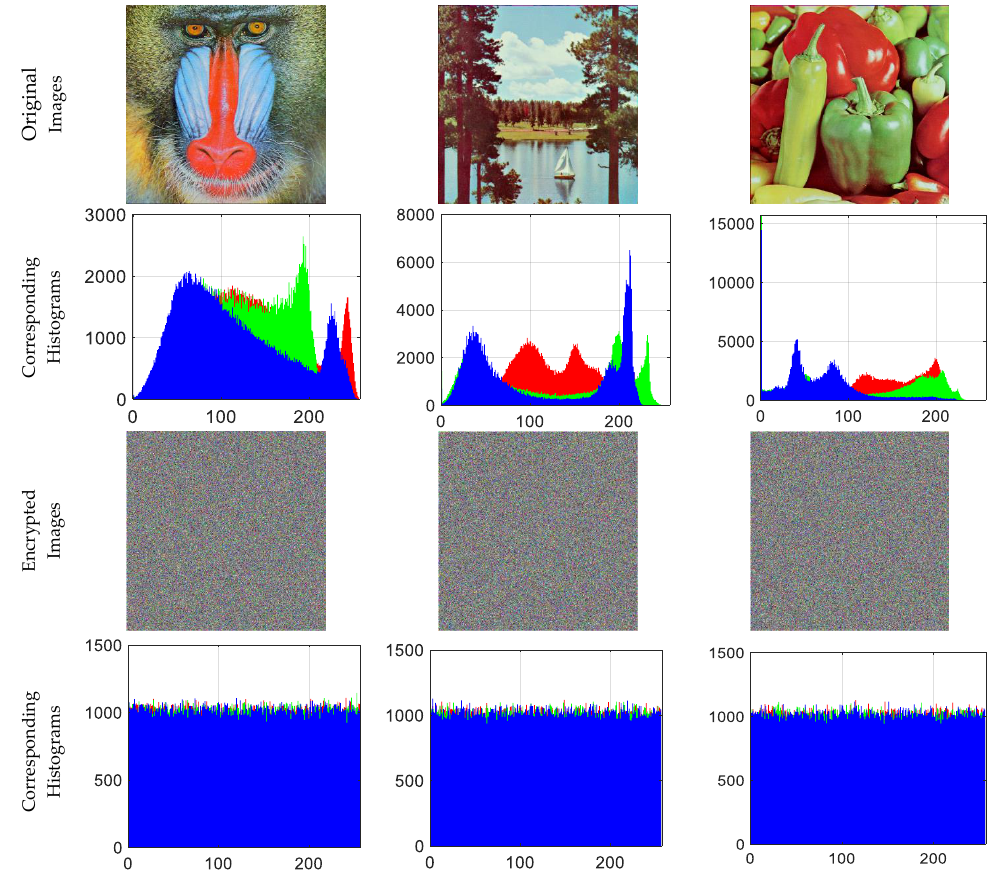
Figure 15. Color test images of size 512 × 512 with their encrypted versions and the corresponding R-, G-, and B-channel